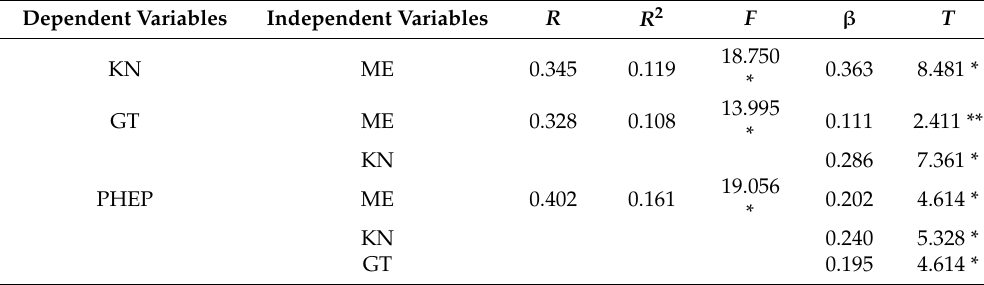
Table 4. Results of regression analysis.